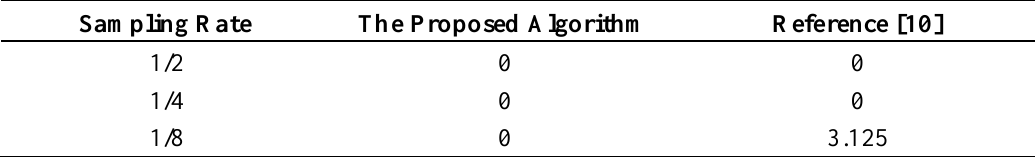
Table 3. Testing results via resampling attack with various sampling rates.